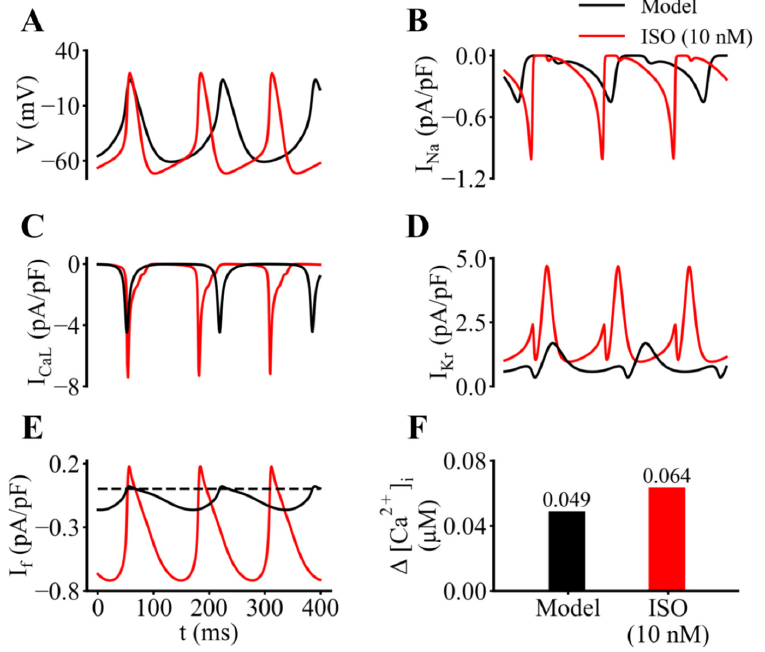
Figure 11. Illustration of the effects of ISO on SAN pacemaker activity and underlying transmembrane ionic currents. Output records generated using the baseline mathematical model is shown in black and data obtained after addition of 10 nM ISO is shown in red. ( A ): Superimposed action potentials and pacemaker depolarizations confirm that ISO application results in an approximately 50% increase in pacemaker firing rate, and also reveal a small hyperpolarization of the maximum diastolic potential. ( B – E ): Corresponding data for the Na + current, I Na ; the L-type Ca 2+ current, I CaL ; the rapid delayed rectifier K + , I Kr current, and the hyperpolarization-activated cation current, I f , respectively. Note that application of ISO approximately doubles the size of I Na and I CaL and that I Kr also increases significantly. The data in Panel C is the focus of this study. Two prominent effects of ISO on I f are shown: (i) there is a significant shift in the inward direction of the steady or background current level, and (ii) the changes in I f during each action potential are increased substantially (4- to 5-fold). ( F ) Increase (approximately 30%) in intracellular Ca 2+ by ISO.